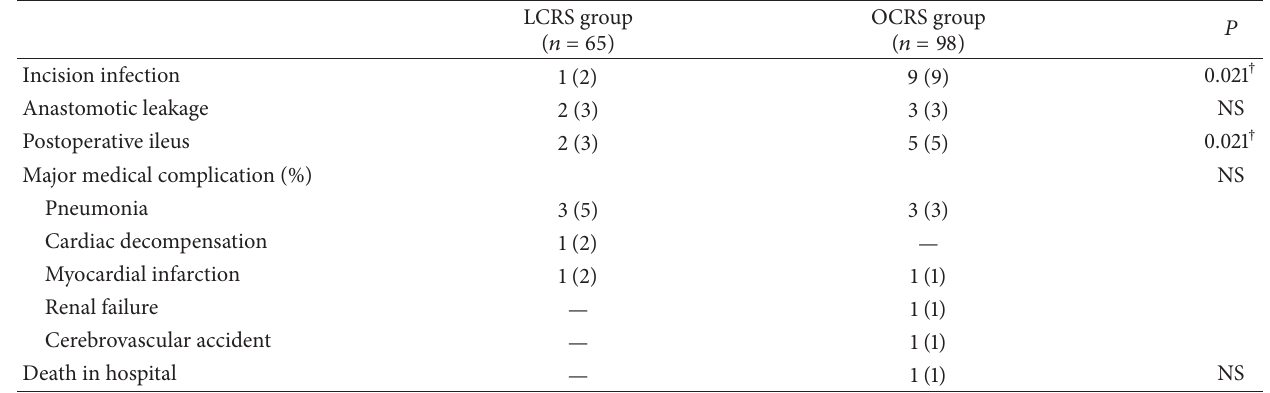
Table 3: Postoperative morbidity and mortality.